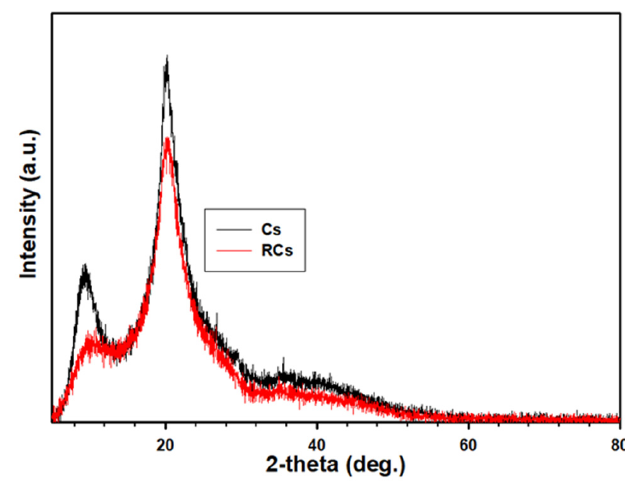
Figure 5. XRD spectra of Cs and RCs.